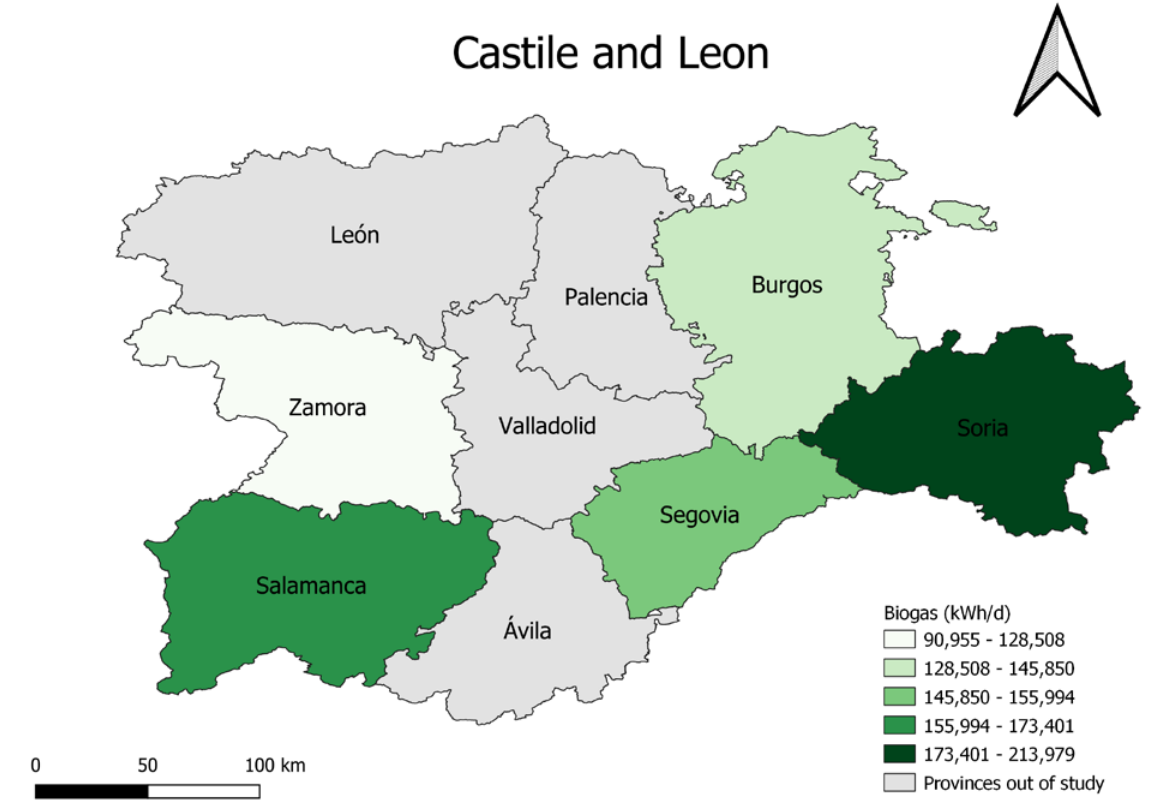
Figure 3. Biogas production of selected farms in Castile y